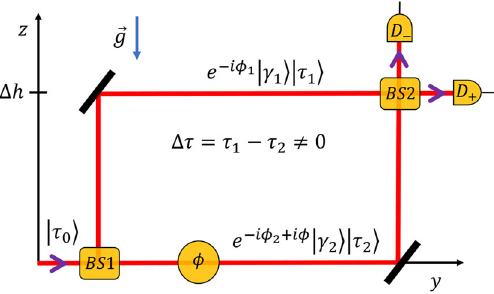
Fig. 3 ThisfigureillustratestheMach-ZehnderinterferometerinFig.1 placedinanexternalgravitationalfield,i.e.undertheinfluenceofagrav- itational acceleration (cid:12) g . The information about the which-way detector WWD is now encoded in an internal time-evolving degree of freedom that works as a clock. Due to time dilation effects, an initial internal state | τ 0 (cid:3) can evolve into a linear combination of the two states characterized by two different proper times, (cid:14)τ = τ 1 − τ 2 (cid:10)= 0 . The phases φ 1 , 2 depend on the path and on the dynamics of the internal degree of freedom, whereas φ is a controllable phase